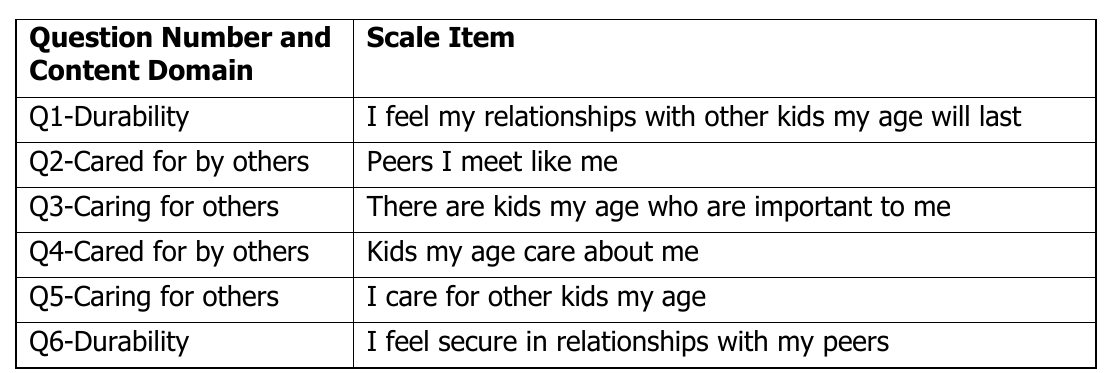
Final Version of the Youth Relatedness Scale: Current Status Items Only